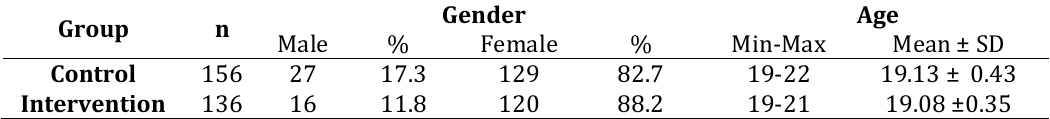
Characteristics of respondents Group n